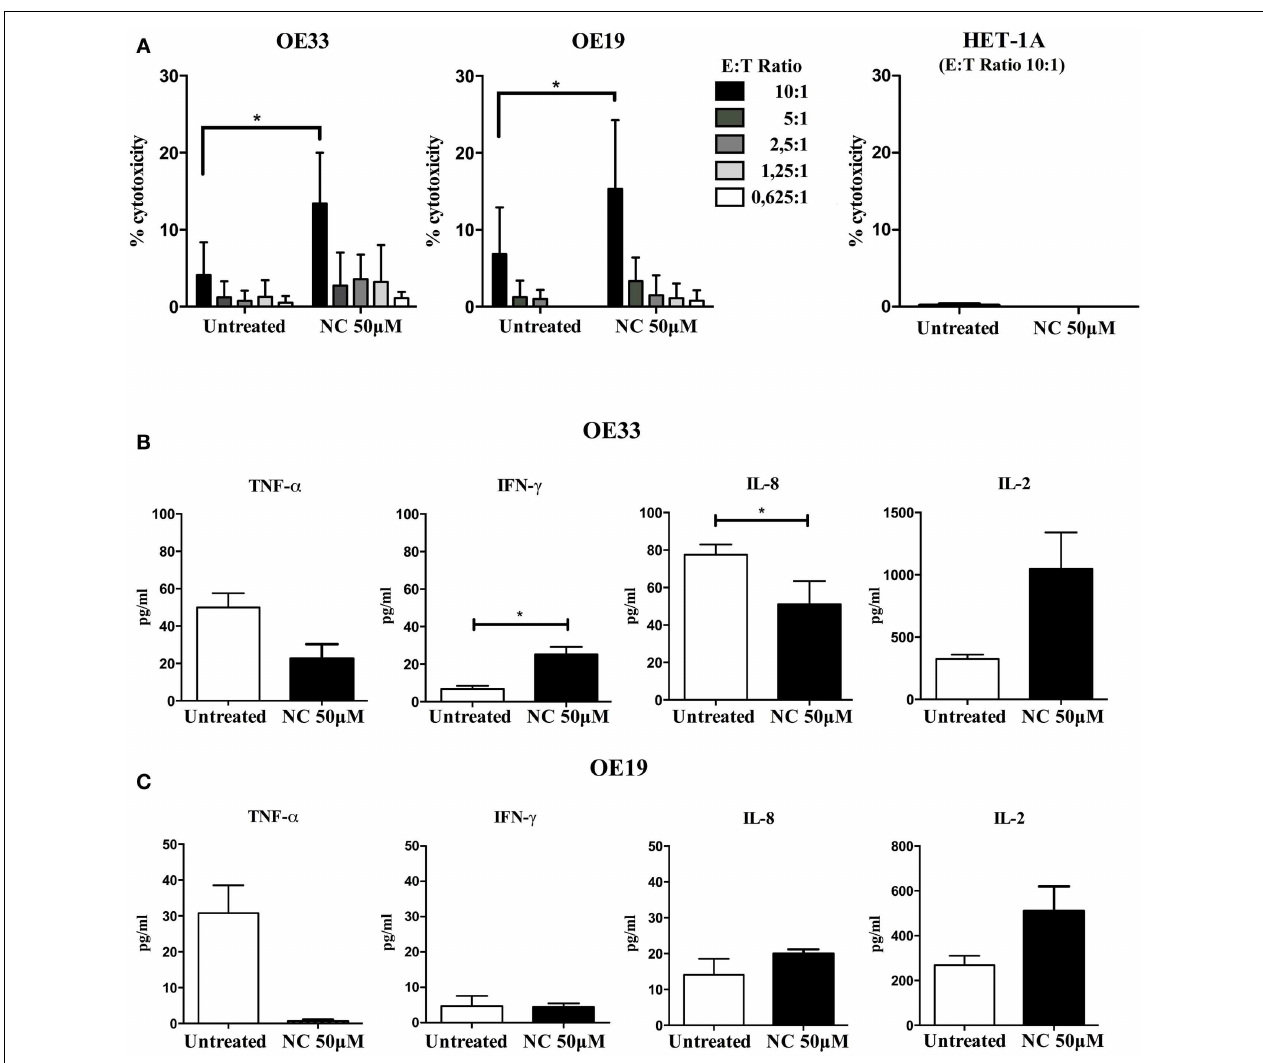
cells, which also does not change after nano-curcumin treatment. (B) The cytokine profile as measured in the supernatant after the cytotoxicity assay shows that in the co-culture of CTLs and OE33, pre-treatment with nano-curcumin increases IFN- γ production and decreases the production of IL-8 (student’s two tailed paired t test, * P < 0.05, n = 3). (C) In the supernatant of the co-culture of OE19 cells with CTLs, pre-treatment with nano-curcumin did not change the cytokine profile (student’s two tailed paired t test, n =